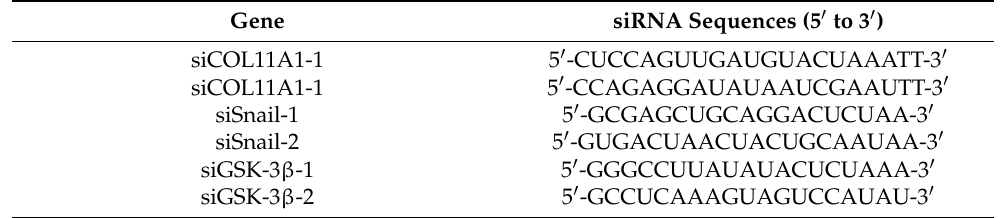
Table 1. Sequences of siRNAs.